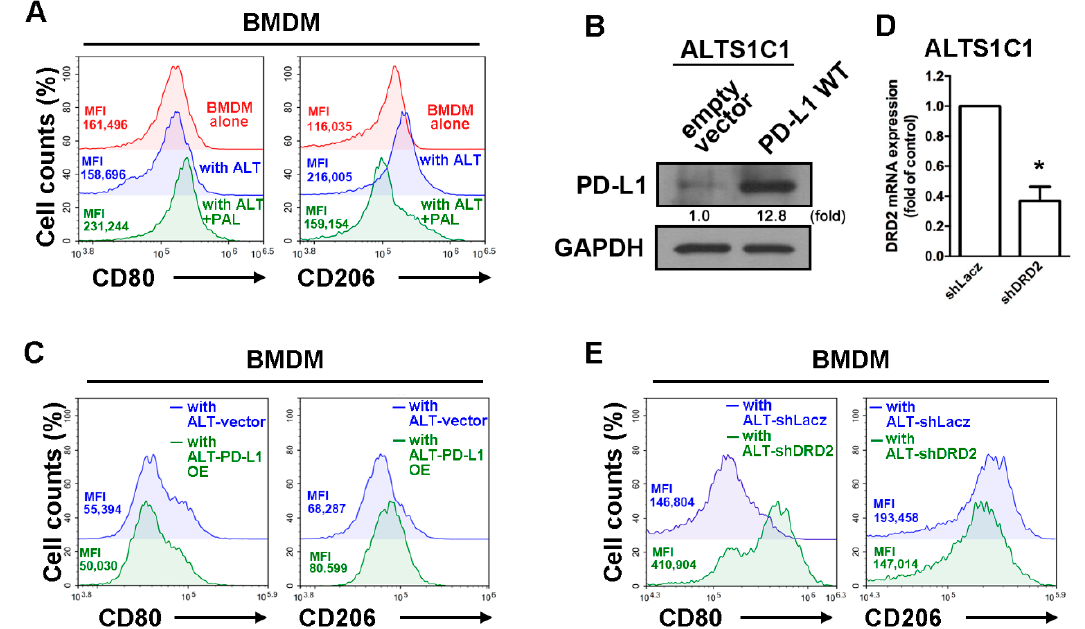
Figure 3. DRD2 and PD-L1 in GBM are involved in the polarization of TAMs in the GBM-macrophage co-cultured system. ( A ) BMDMs were co-cultured with ALTS1C1-GFP cells and then treated with or without PAL (20 µ M) for 48 h. CD80 and CD206 expressions were determined by flow cytometry analysis. ( B ) Establishment of stable PD-L1 expression in ALTS1C1-GFP cells. The expression of PD-L1 was verified by Western blot. ( C ) BMDMs were co-cultured with PD-L1 ALTS1C1-GFP cells for 48 h. CD80 and CD206 were determined by flow cytometry analysis. ( D ) ALTS1C1-GFP cells were transfected with DRD2, and the expression of DRD2 was verified by real time-PCR. * p < 0.05 compared with shLacz group. ( E ) BMDMs were co-cultured with DRD2 knockdown of ALTS1C1-GFP cells for 48 h. CD80 and CD206 were determined by flow cytometry analysis.